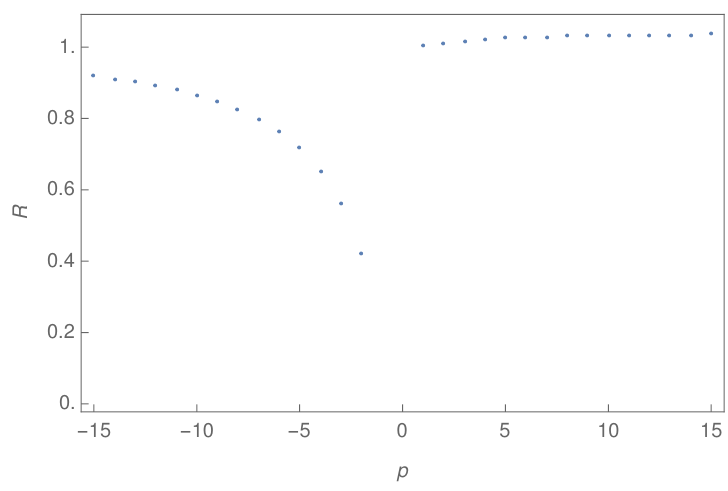
Figure 3 . The recombination factor of the foregoing non-BPS black string for various values of p